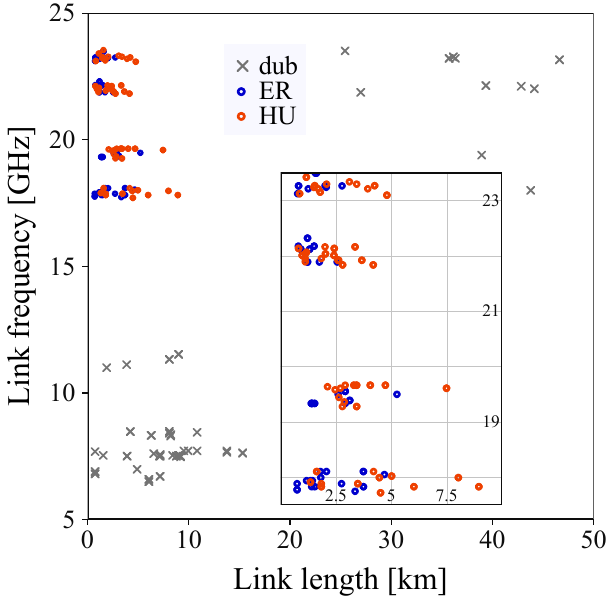
Figure 2. Scatter plot of frequency against link length for all 213 CMLs (149 ER and 66 HU) shown in Fig. 1. The orange circles are the 54 HU CMLs, the blue circles are the 91 ER CMLs, and the grey markers are those (68) CMLs with frequencies below 15GHz or link lengths above 20km. Inset, there is a zoom into the “not- dubious” region of frequency vs. link length commonly found in commercial link networks worldwide.